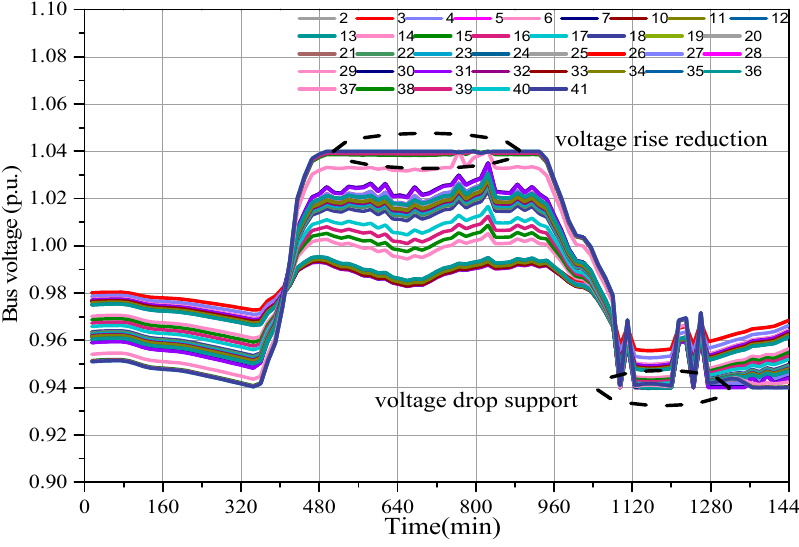
Figure 9. Curves of node voltages in Case 4. Table 6. Results of price arbitrage.